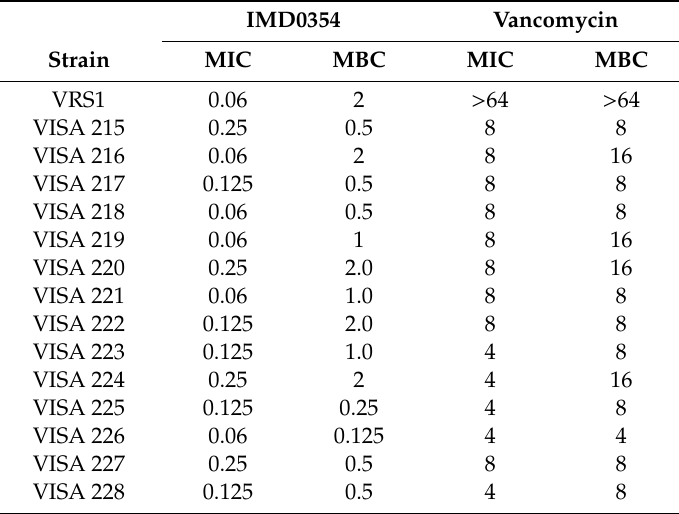
Minimum inhibitory concentration ( µ g / mL) of NF- κ B inhibitors IMD0354 against vancomycin-resistant Staphylococcus aureus (VRSA) and vancomycin-intermediate Staphylococcus aureus (VISA) clinical strains. IMD0354